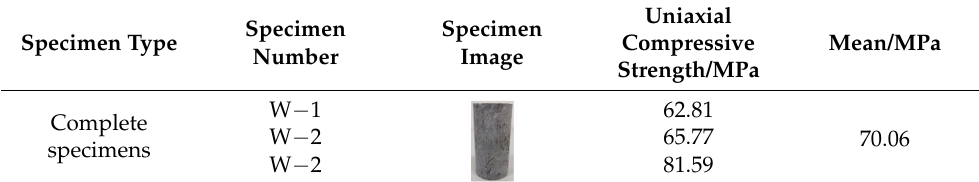
Table 2. Uniaxial compressive strength of each